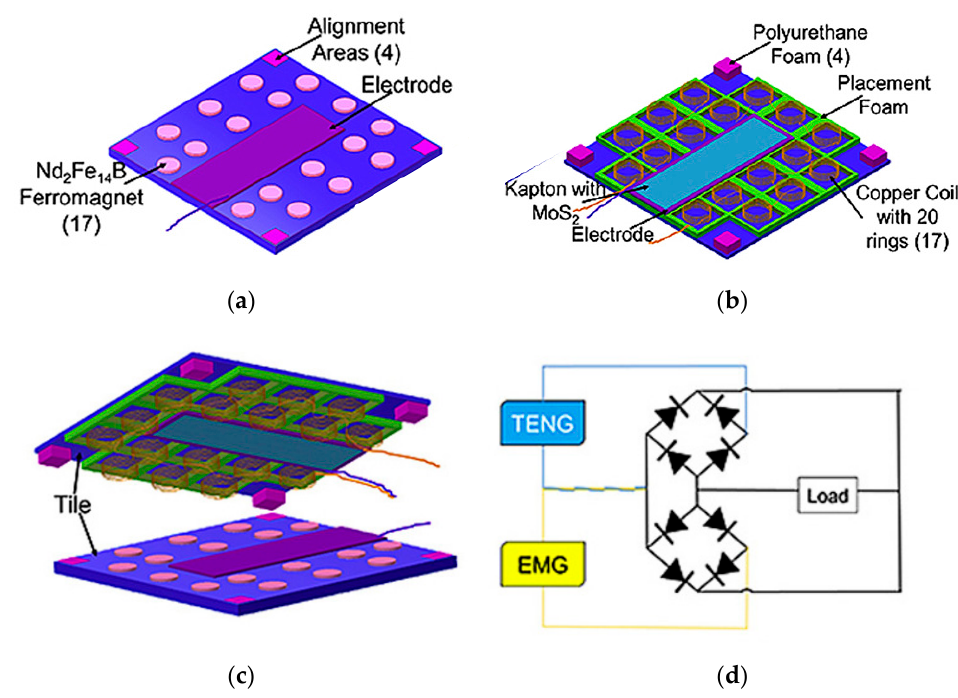
Figure 25. Layer with magnets and the electrode for the triboelectric generator ( a ); layer with copper coils ( b ); layers that make the tile ( c ); rectifying circuits ( d ) [61].